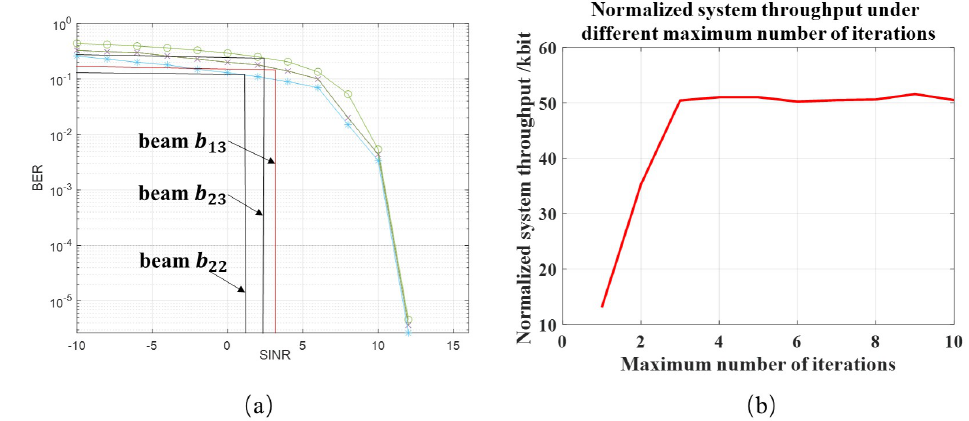
Figure 11. ( a ) The relationship between SNR and BER of different beams. ( b ) Impact of different iterations on normalized system throughput.